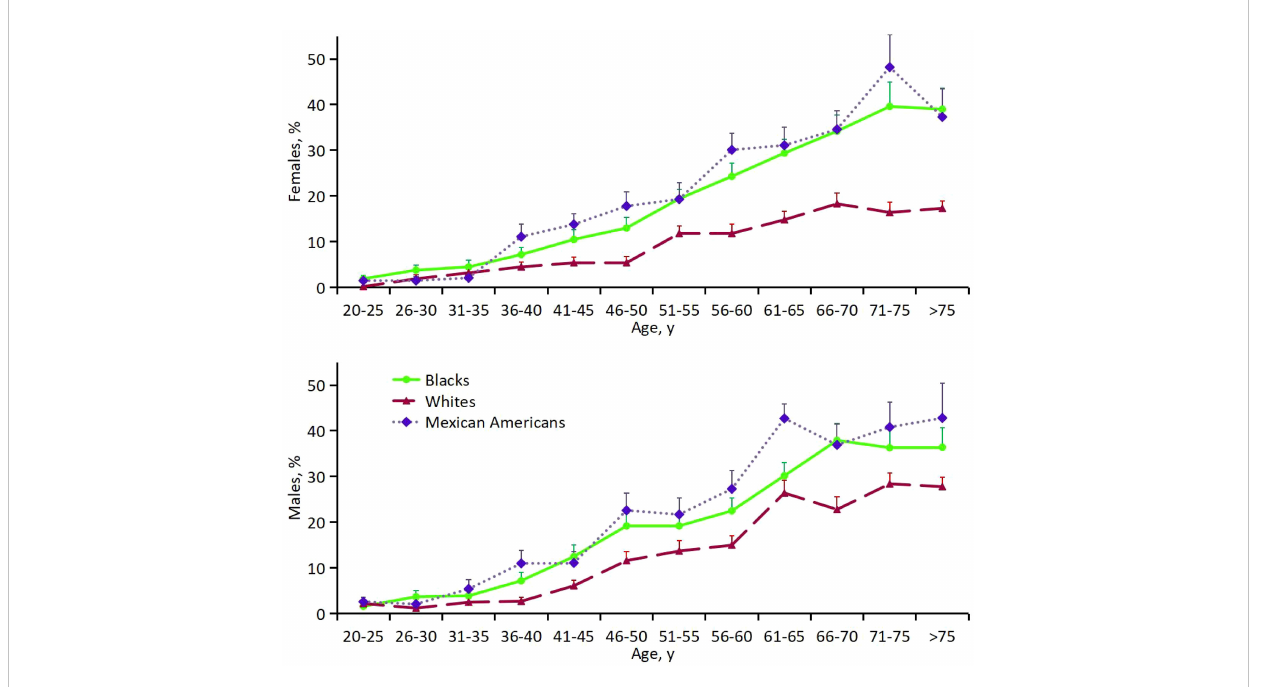
FIGURE 3 Percentage of females (top) and males (bottom) with